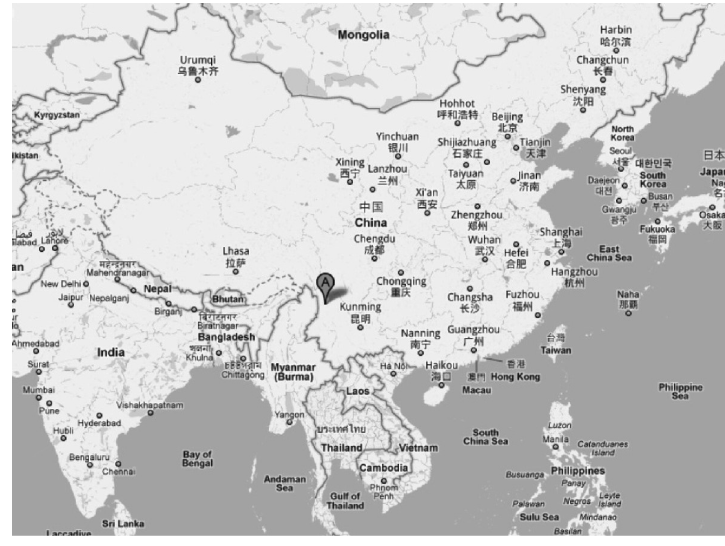
Figure 1: Location of Yushi Village